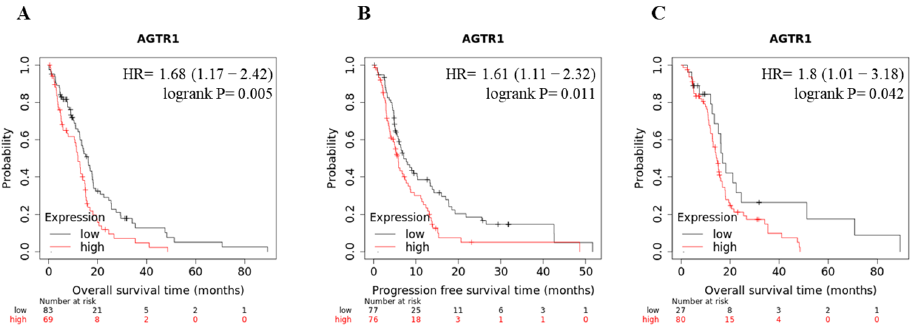
Figure 2. AGTR1 and clinical outcomes in GBM patients. Kaplan–Meier survival analysis relating AGTR1 levels and overall survival (OS) ( A ), progression-free survival (PFS) ( B ), OS in chemotherapy- treated ( C ) GBM patients (TCGA